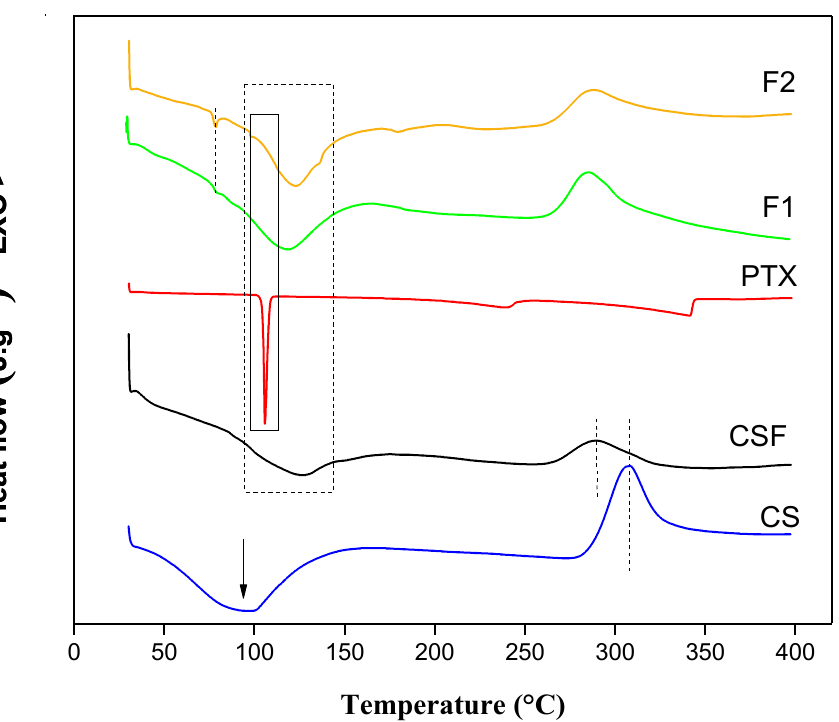
Figure 4. Differential scanning calorimetry thermograms of CS (chitosan, blue line), CSF (chitosan films, black line), PTX (pentoxifylline, red line), F1 (2 mg/mL of pentoxifylline, green line), and F2 (4 mg/mL of pentoxifylline, golden line) components.